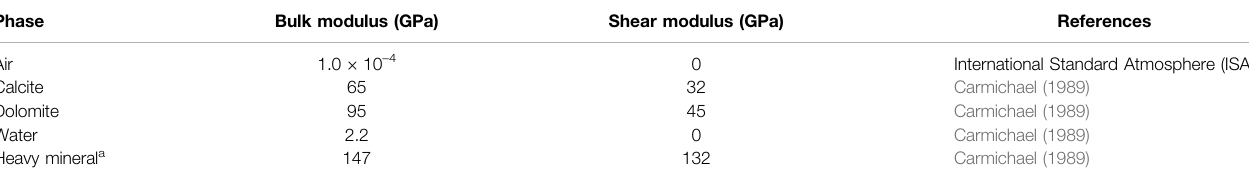
TABLE 3 | Elastic properties of minerals and